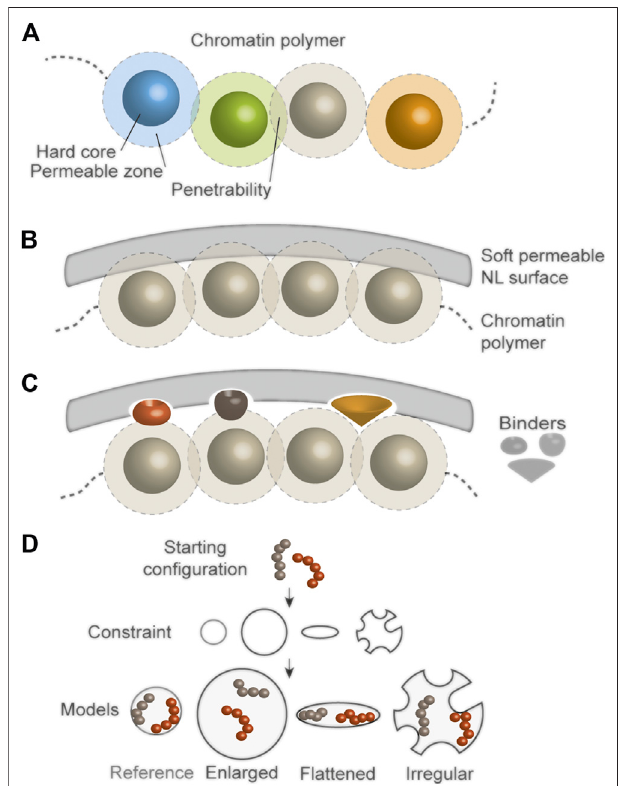
FIGURE 5 | Perspectives on modeling chromatin-NL interactions (A) To enhance fl exibility of a chromatin polymer, beads may be fi tted with a permeable zone (limited by a hard core to prevent full bead clash) and an adjustable penetrability factor, to enable more realistic models of heterochromatin, and models of euchromatin interactions occurring as promoter-enhancer contacts (Siersbaek et al., 2017) or enhancer communities (Madsen et al., 2020) in transcriptionally active regions (B) A permeable zone can be similarly formulated within a NL surface to allow chromatin penetrance into the NL (C) Factors mediating chromatin anchoring with, or release from, the NL (binders) may also be introduced to re fi ne chromatin-NL dynamics in biologically more relevant contexts than current models (D) Imposing nuclear envelope shape constraints in restraint-based genome models would allow predictions on 3D chromatin architecture in physiological contexts (e.g., fl attened nuclei in adipocytes) or in pathological conditions (e.g., irregular nuclei in HGPS or